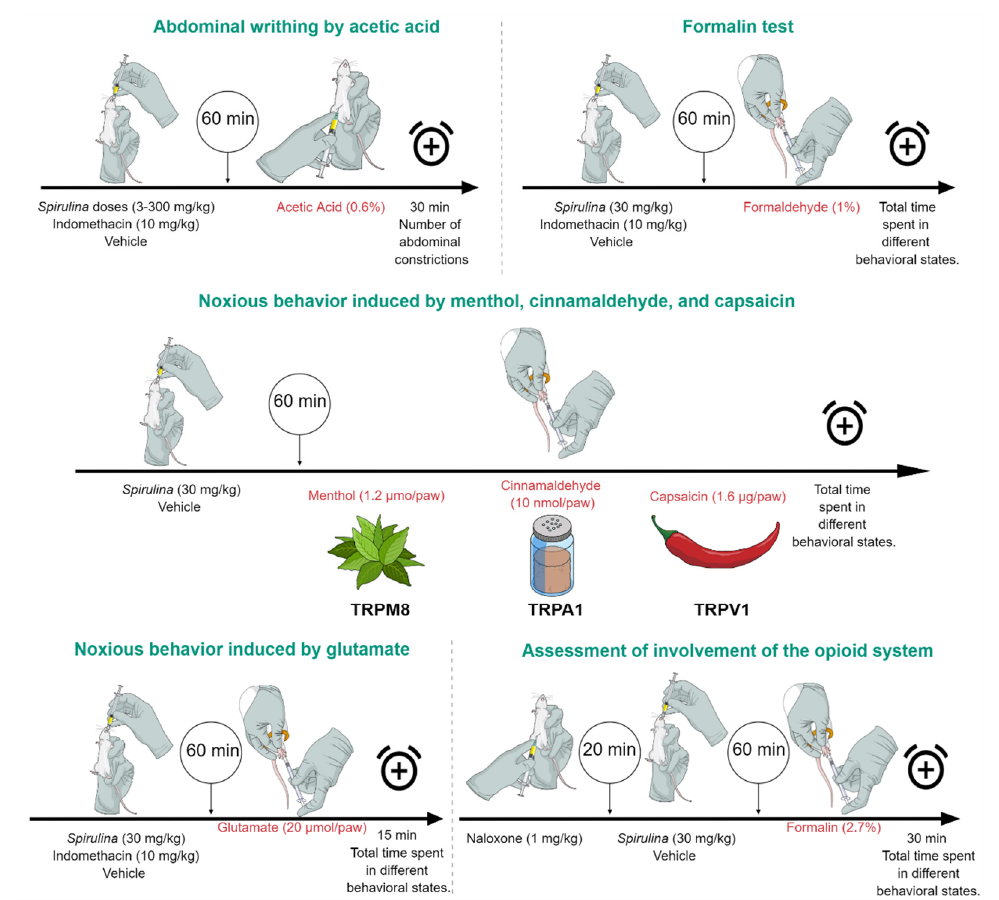
Figure 1. Experimental design. The acetic acid abdominal writhing protocol evaluated the pretreatment with Spirulina (3–300 mg/kg, p.o.), indomethacin (10 mg/kg), or vehicle (0.9% NaCl 10 mL/kg), and after 60 min, 0.6% acetic acid was administered via i.p. to assess the nociceptive behavior. In the formalin test, its application occurred viai.pl. after 60 min of treatment and the time spent in different behavioral states was evaluated. The harmful behavior induced by the menthol, cinnamaldehyde, and capsaicin protocol was administered i.pl. after 60 min of treatment and aimed to assess the involvement of TRPM8, TRPA1, and TRPV1, respectively. The glutamatergic system’s involvement was analyzed with the administration of glutamate (20 µ mol/paw) via i.pl. and the time spent in different behavioral states was evaluated for 15 min. To assess the involvement of the opioid system, a pretreatment with naloxone (1 mg/kg, i.p.) was administrated 20 min before treatment with Spirulina (30 mg/kg, p.o.), and after 60 min, nociceptive behaviors were eval- uated.